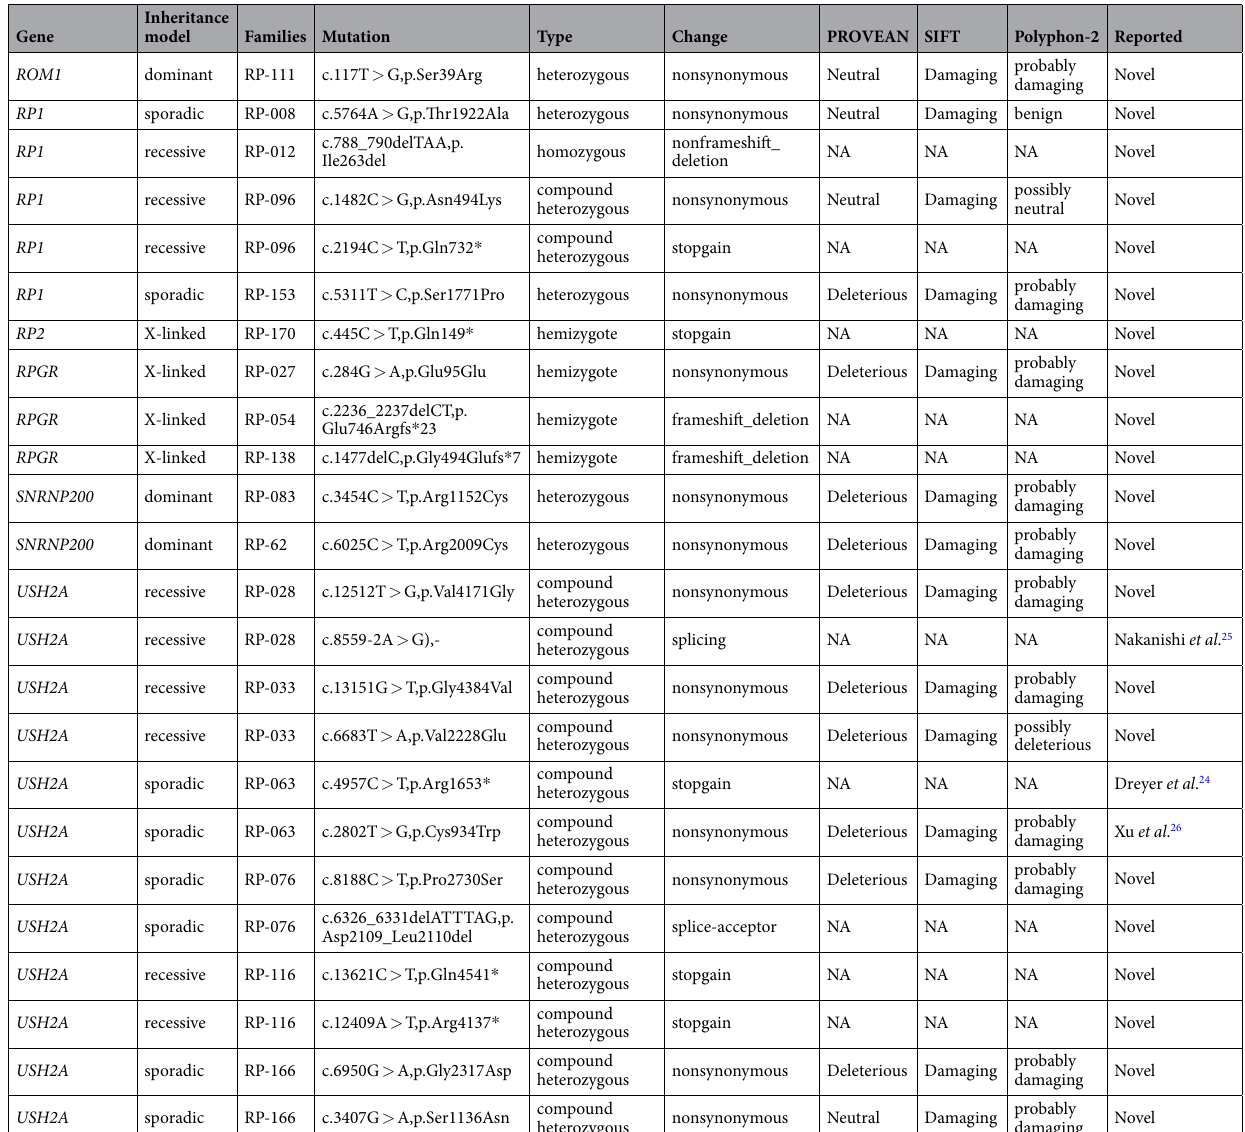
Table 1. The 57 potential pathogenic mutations in 77 known RP genes in the 40 of the 98 small Han Chinese families with RP. The mutations were filtered with the following multiple-step bioinformatics analysis: 1) the SNPs and short indels in the exome region were filtered against data from 1000 genome, dbSNP135-common, ExAC and unrelated individuals of 2020 in-house non-RP controls, removing minor allele frequency (MAF) values that were greater than 0.005 for recessive model and any frequency for dominant model; 2) excluded non-coding variants without altering splicing sites; 3) excluded the synonymous variants without altering splicing sites in the genes; 4) excluded missense variants predicted to be Neutral/Tolerated /Benign by PROVEAN, SIFT and